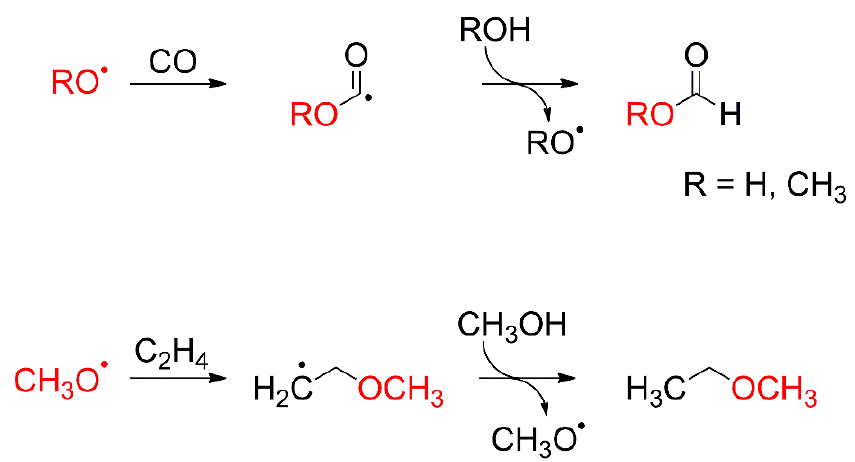
Scheme 4. Reaction of H 2 O or CH 3 OH with CO yielding formic acid and methyl formate, respectively, and reaction of CH 3 OH with C 2 H 4 yielding ethyl methyl ether. The reactions can be initiated by DEA to CO at E 0 = 10 eV yielding C and O •− , or by ND, EI, or DEA to CH 3 OH. Note that DEA to CO is not accessible in C 2 H 4 /CH 3 OH mixed ices.